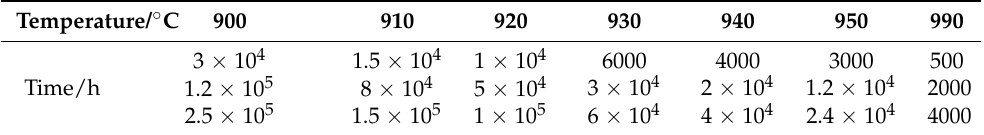
Table 2. Aging time versus operating time of HP40Nb alloy. Temperature/ ◦ C